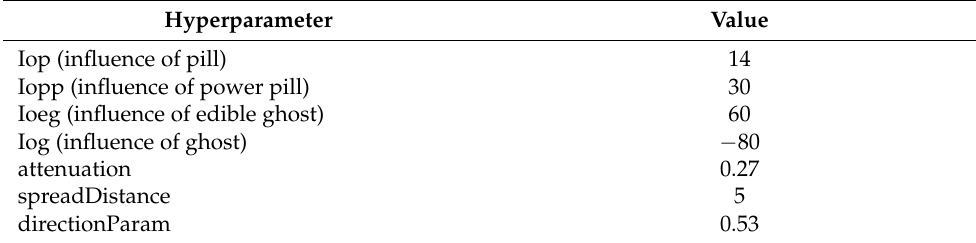
Table 3. Hyperparameters in the influence map.